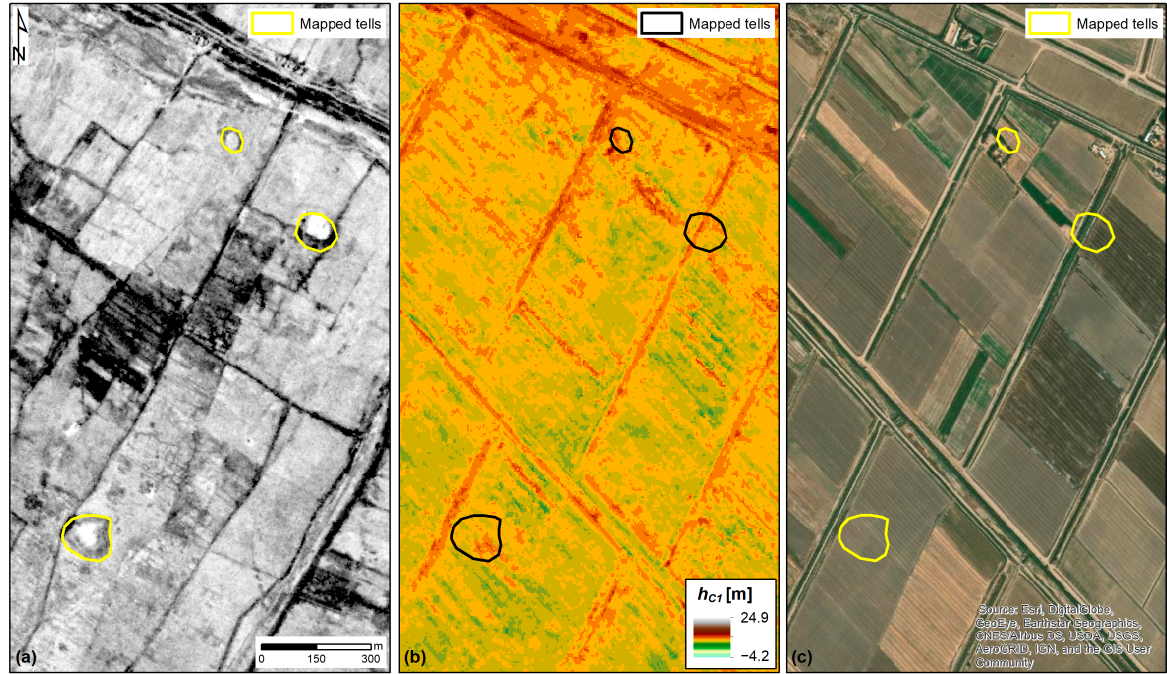
Figure 13. Example of tells (precise location undisclosed for security concerns) where ‘leveling and flattening’ led to conversion to crop fields and further damage due to ‘agriculture’, as documented by multi-temporal analysis of ( a ) CORONA imagery and ( b ) CartoSat-1 DSM (©GAF AG. Includes material ©Antrix, distributed by GAF AG), and contextual information from ( c ) Google Earth image (©2021 Maxar Technologies) collected on 9 April 2002.